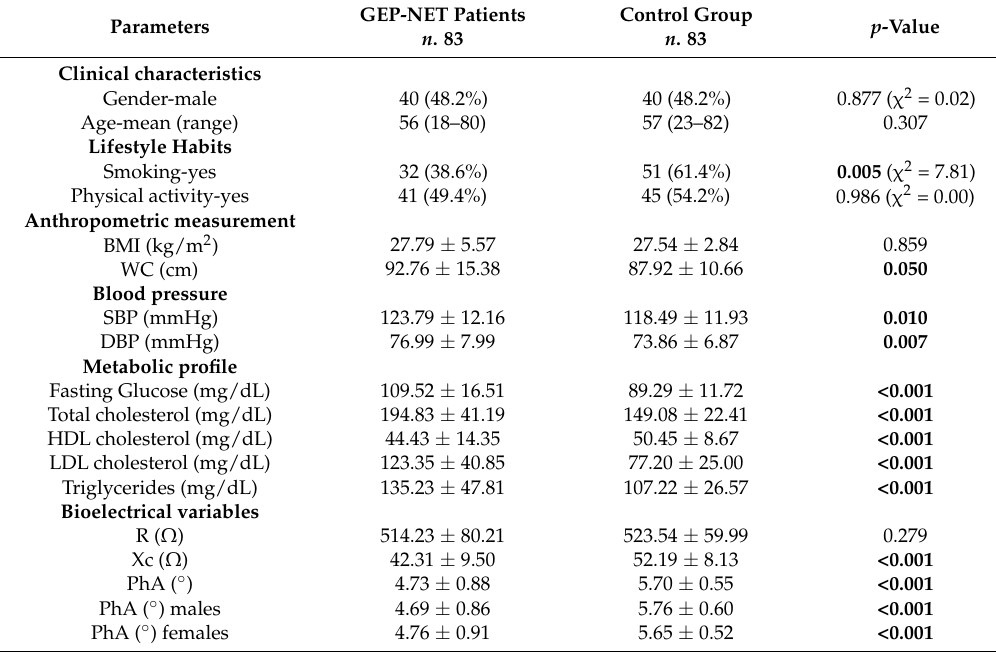
Table 1. Demographic, clinical, metabolic, and bioelectrical parameters of GEP-NET patients compared to